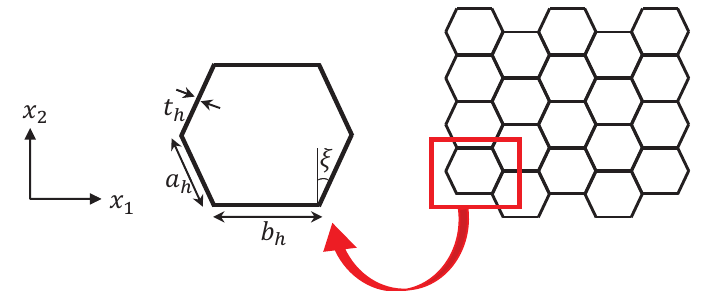
Figure 3. Geometry and dimensions of the cell of the honeycomb